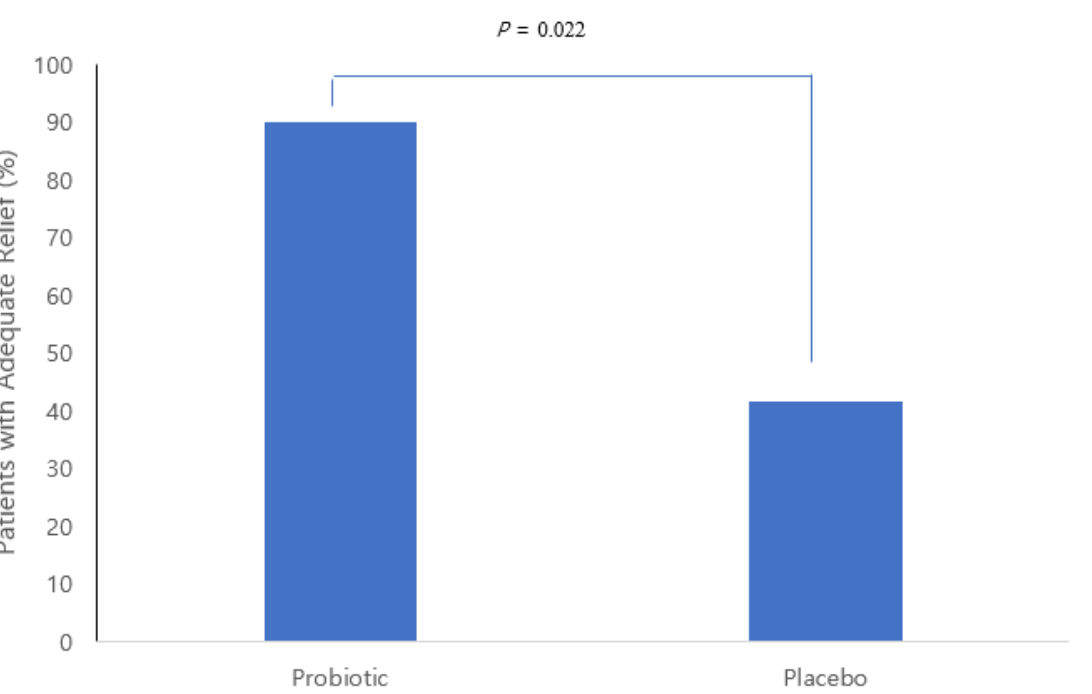
Figure 2. Percentage of patients with adequate FD relief at two months.